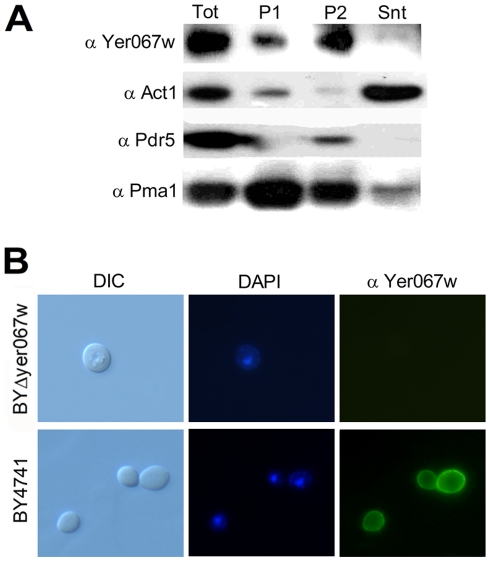
Localization analysis of Yer067w.(A) Western blot analysis of cell fractionation by differential centrifugation reveals that Yer067w is localized in cell membranes. Total protein extract was obtained from BY4741 grown overnight in glycerol. Tot, total protein extract; P1, fraction sedimented after 12,000 g centrifugation; P2, fraction sedimented after 100,000 g centrifugation; and Snt, soluble fraction collected from 100,000 g centrifugation step. (B) Immunolocalization of Yer067w. Images were collected from wild type BY4741 and the BYΔyer067w strain. Yer067w specific signal was visualized using anti-Yer067w primary antibody and 488-ALEXA conjugated secondary antibodies. DAPI-stained DNA (blue) signals and Nomarski (DIC) images were also recorded. The exposure time used for image acquisition was equal for both strains.